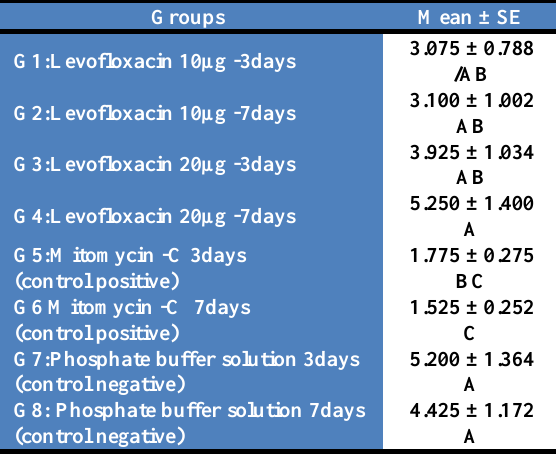
Table, 1: Mitotic index of chick's embryo in two different stages (3 and 7 days of incubation) exposed to two different concentrations of Levofloxacin.